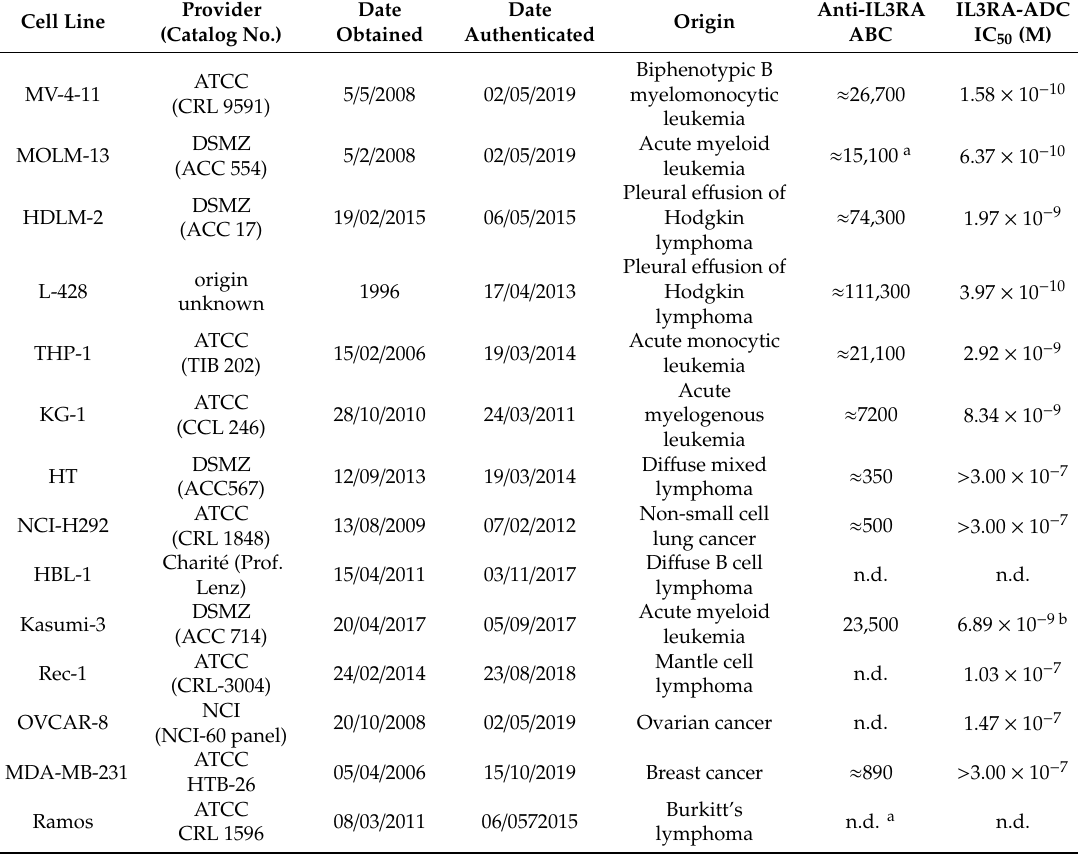
Table 1. The antiproliferative activity of IL3RA-ADC in a panel of tumor cells. Cell Line